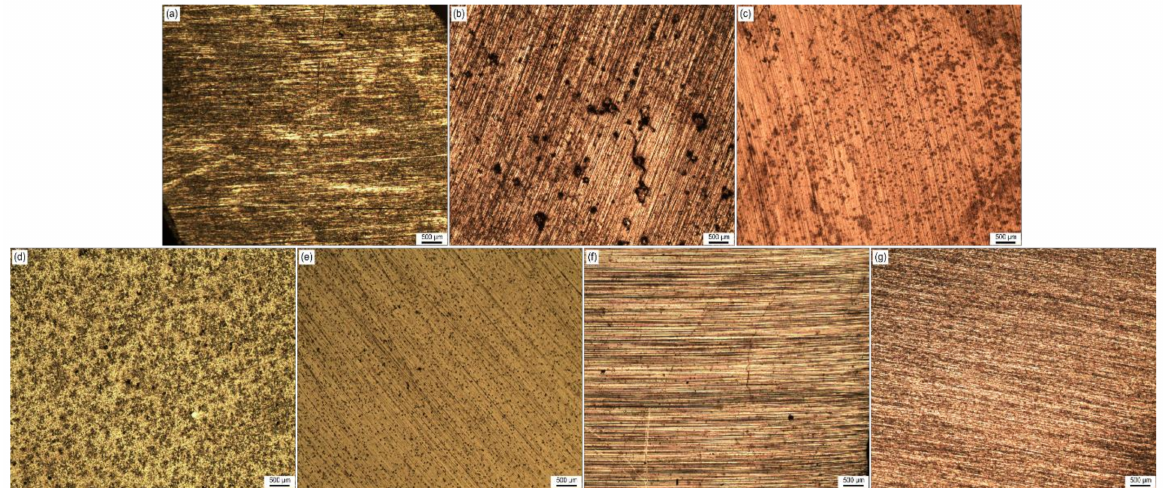
Figure 11. Optical microscopies of thermomechanically treated samples after testing in FA pore solution containing 0.6 M NaCl ( × 5): ( a ) As received, ( b ) Annealing, ( c ) Normalizing, ( d ) Water quenching, ( e ) Oil quenching, ( f ) subcritical annealing after water quenching, and ( g ) subcritical annealing after oil